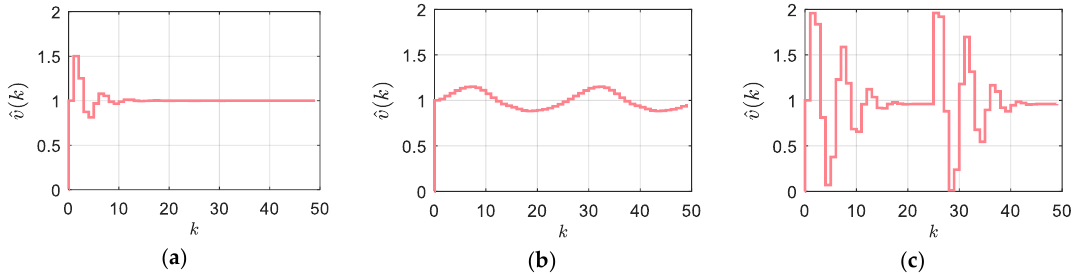
Figure 3. Step response of the DLMT filter: ( a ) constant δt k / T s = 0.5; ( b ) sinusoidal variation of δt k / T s; ( c ) sawtooth variation of δt k / T s .